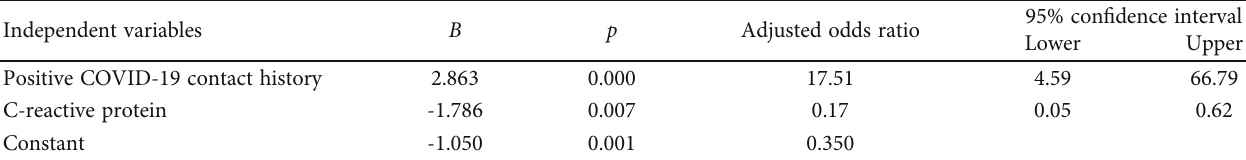
Table 3: Stepwise multiple logistic regression of factors a ff ecting positive COVID-19